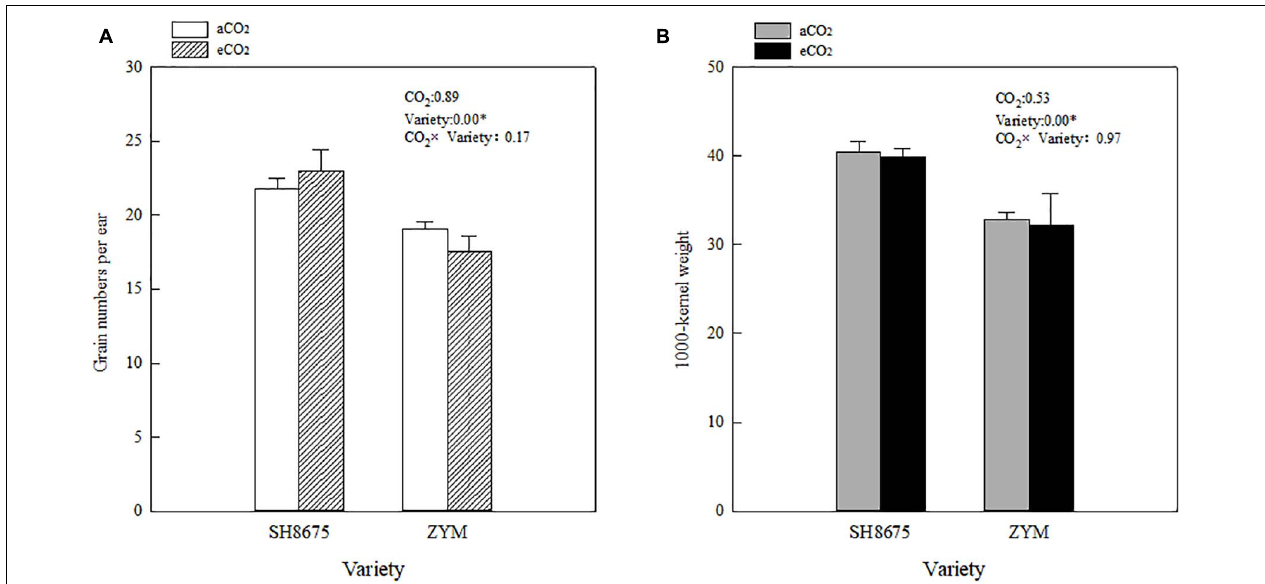
FIGURE 6 | Effects of elevated CO 2 on grain number per ear and 1,000-kernel weight of two winter wheat varieties (A,B) . Measurements were carried out at maturity stage. Data represent the mean of three plants from each plot ± SD (standard error) bars. ANOVA results with * indicate significance at p < 0.05.